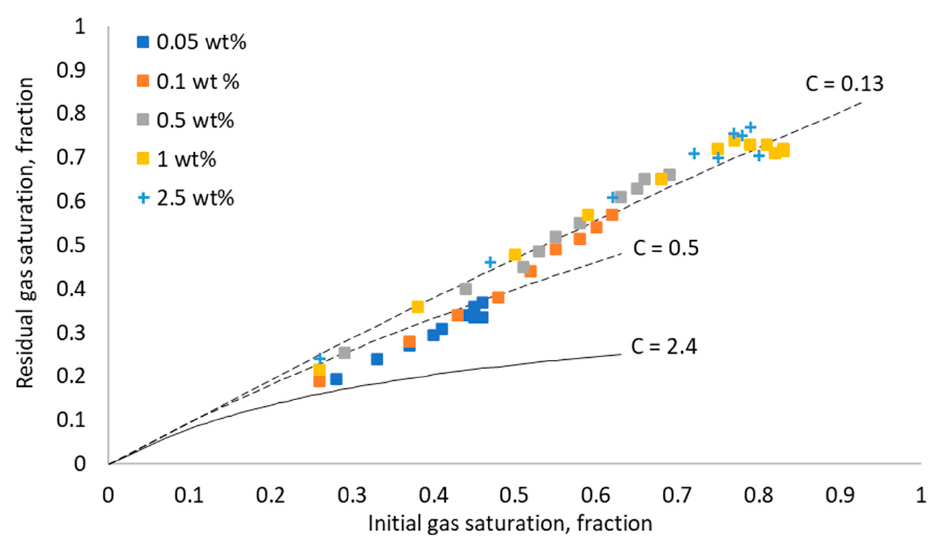
Figure 11. Initial–residual saturation curves of the B sample under SAG injection conducted with various surfactant concentrations. The solid and dashed lines show Land’s model fitting using various values of the C coefficients.